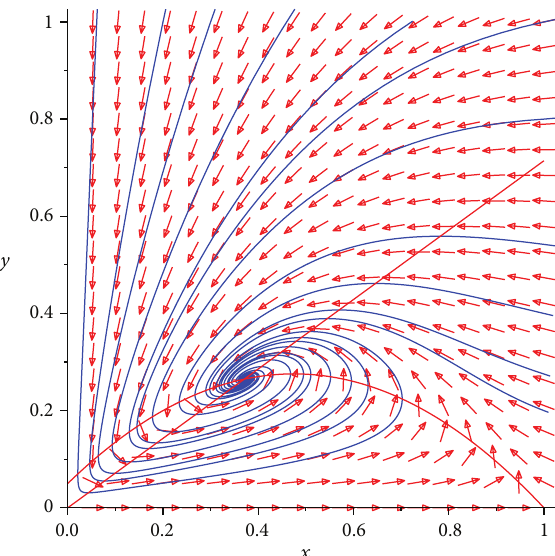
Figure 1: Illustration of vector graph of system (11), where 𝑎 = 0.05 , 𝛿 = 0.5 , 𝛽 = 0.7